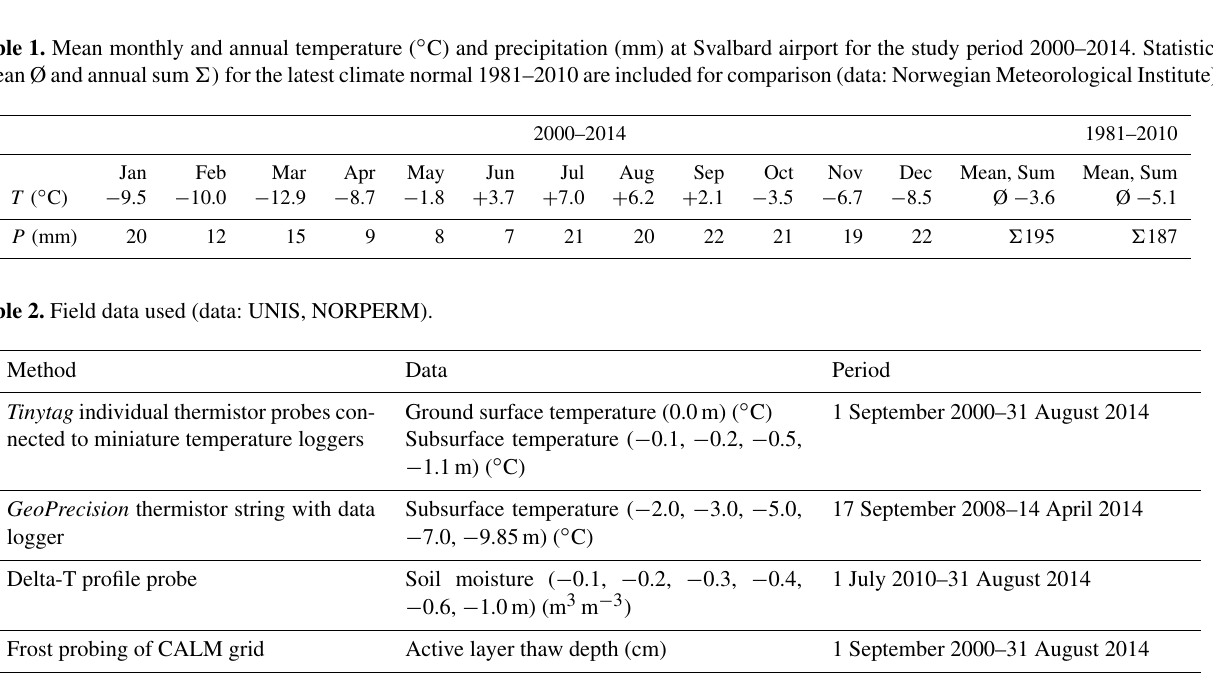
Table 1. Mean monthly and annual temperature ( ◦ C) and precipitation (mm) at Svalbard airport for the study period 2000–2014. Statistics (mean Ø and annual sum (cid:54)) for the latest climate normal 1981–2010 are included for comparison (data: Norwegian Meteorological Institute).